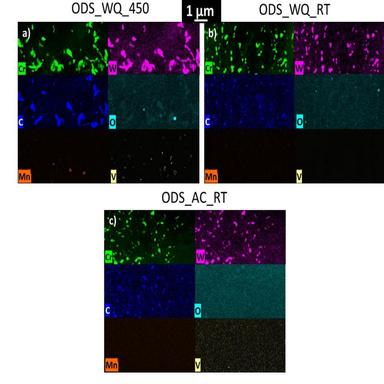
STEM-EDX element mappings of a) ODS_WQ_450, b) ODS_WQ_RT and c) ODS_AC_RT showing sub-micron particles predominantly enriched with Cr, W and C (maps were not normalized to enhance contrast between elements) with additional minor enrichments in O, Mn and V (shown in normalized maps).